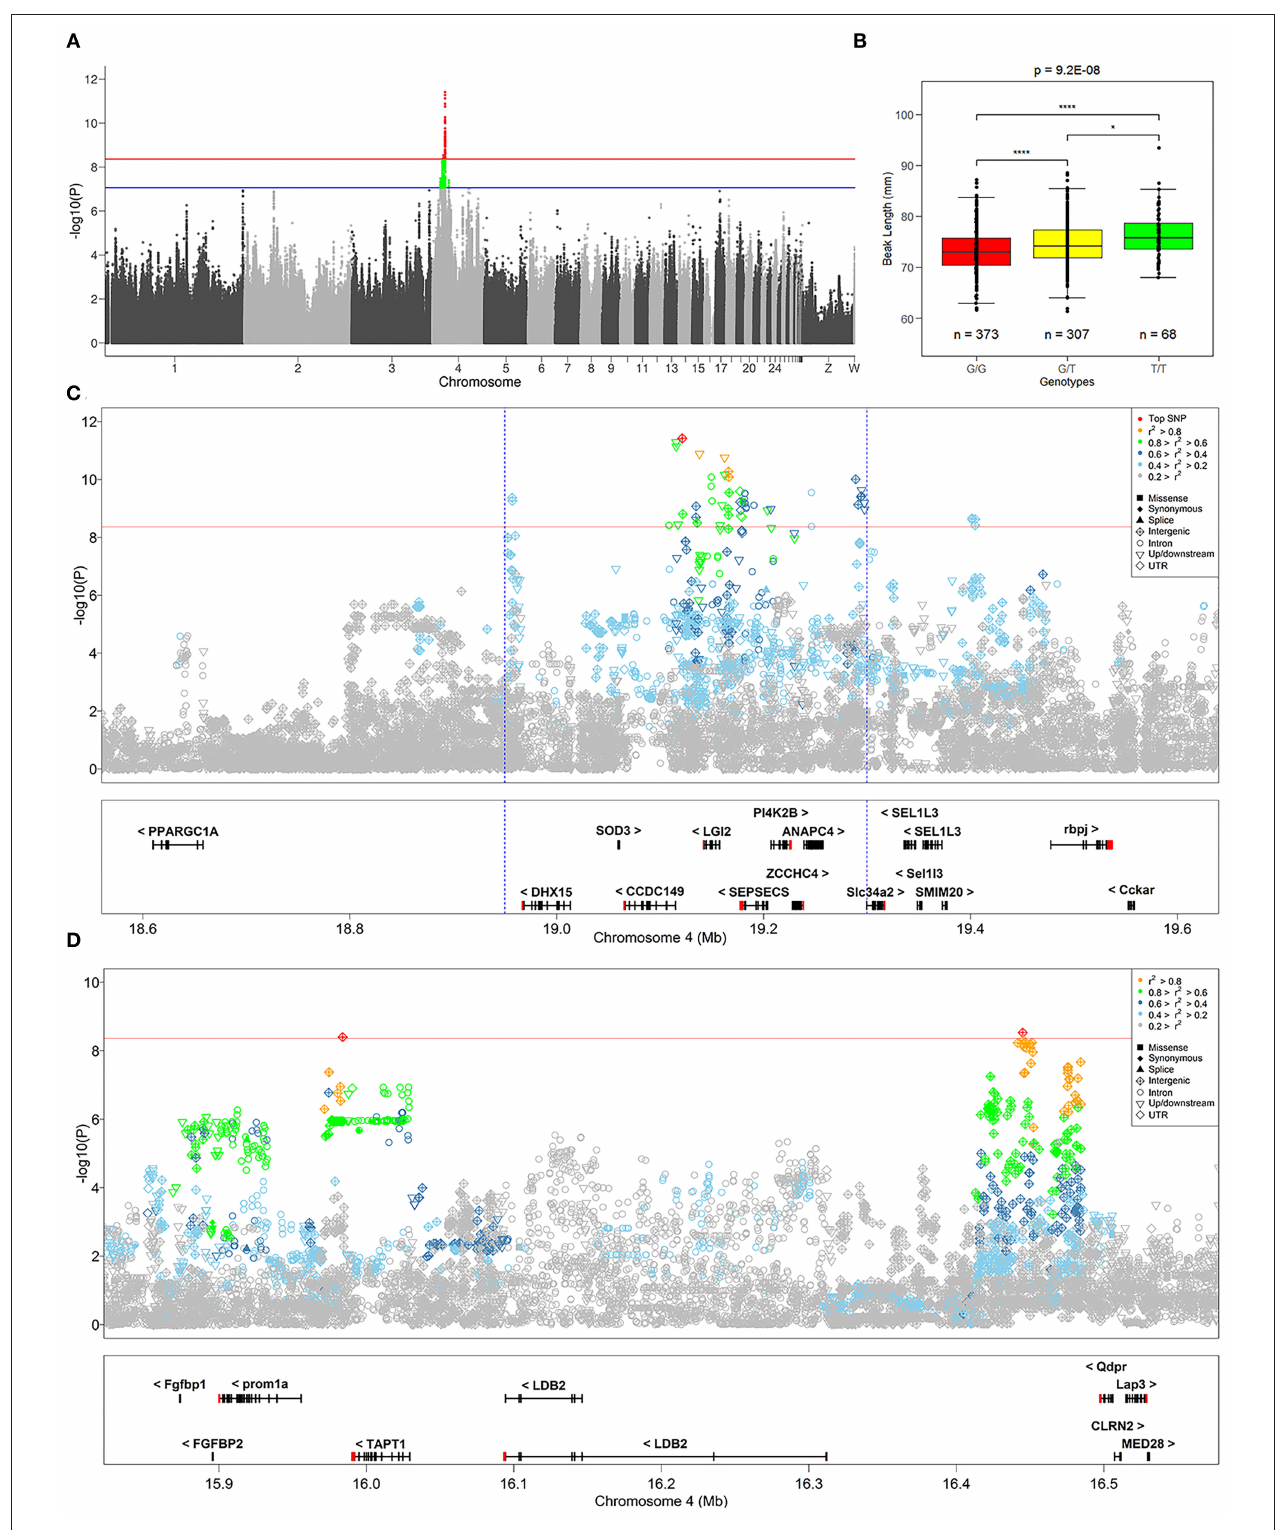
FIGURE 2 | Summary of GWAS results. (A) Manhattan plot of GWAS for the beak length trait. The red and blue lines at points indicate significance thresholds at the genome and chromosome level, respectively. (B) Distribution of genotypes of the most significant SNP identified by GWAS in the beak length data. *Indicates P < 0.05, ****Indicates P < 0.01, and “ n ” indicates the number of samples. (C,D) Show the regional association plots of the loci of SNPs that are significantly